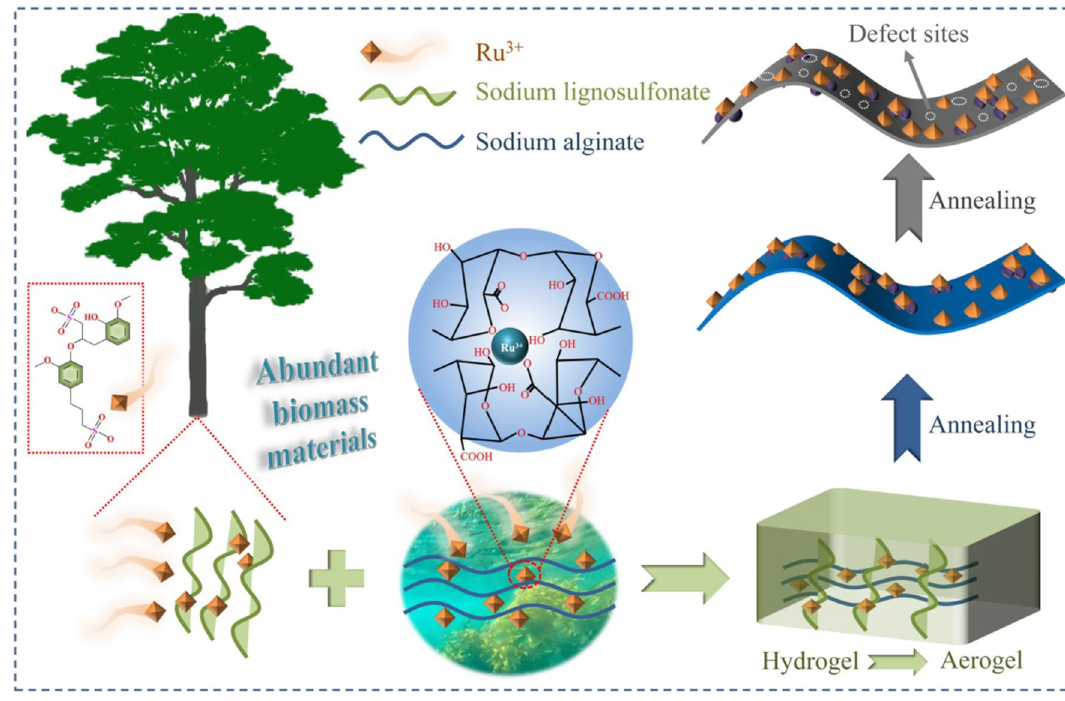
Fig. 1 Schematic illustration of the synthesis process of Ru/RuS